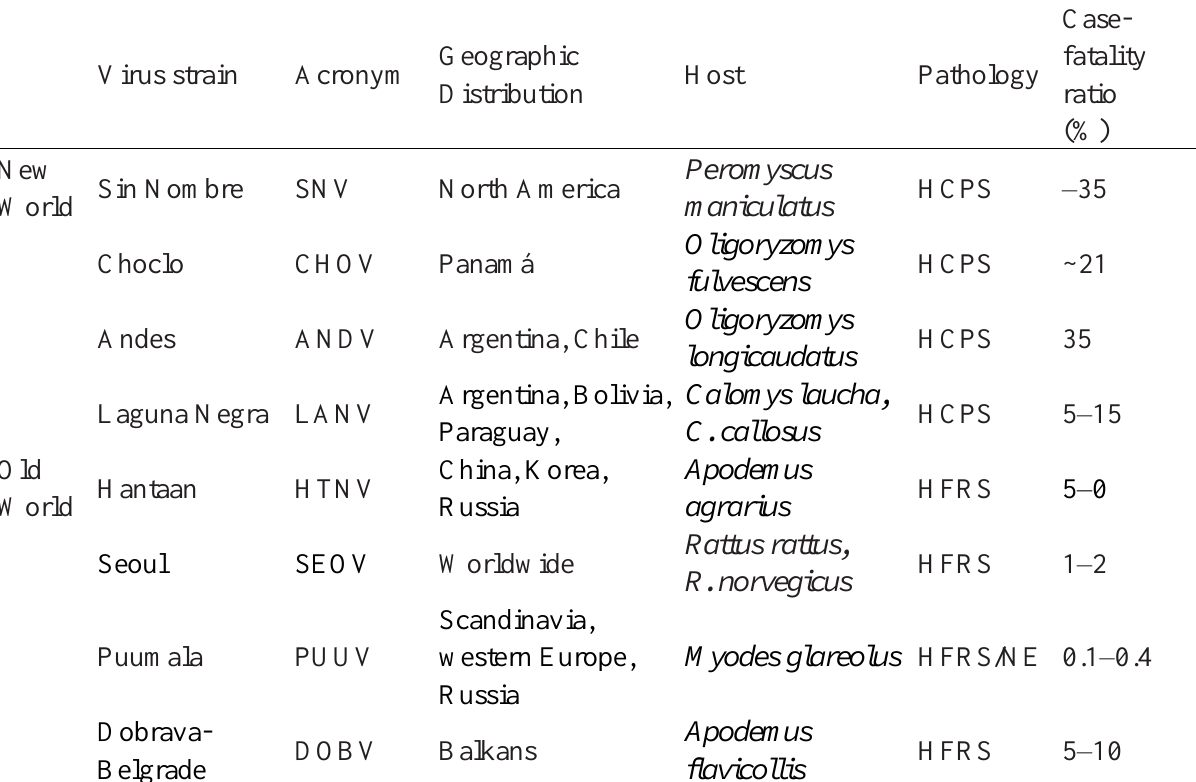
Table 1. Major human-pathogenic